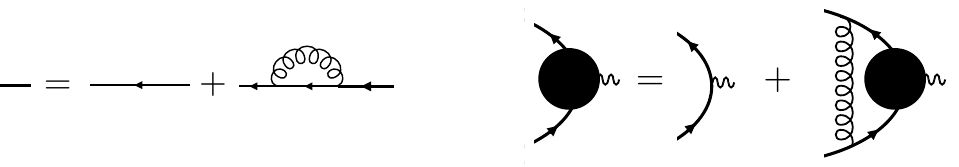
Figure 3 . Illustration of the Bethe-Salpeter equations; the resummed propagator with self-energy insertions (left) and the resummed vertex with ladder diagrams